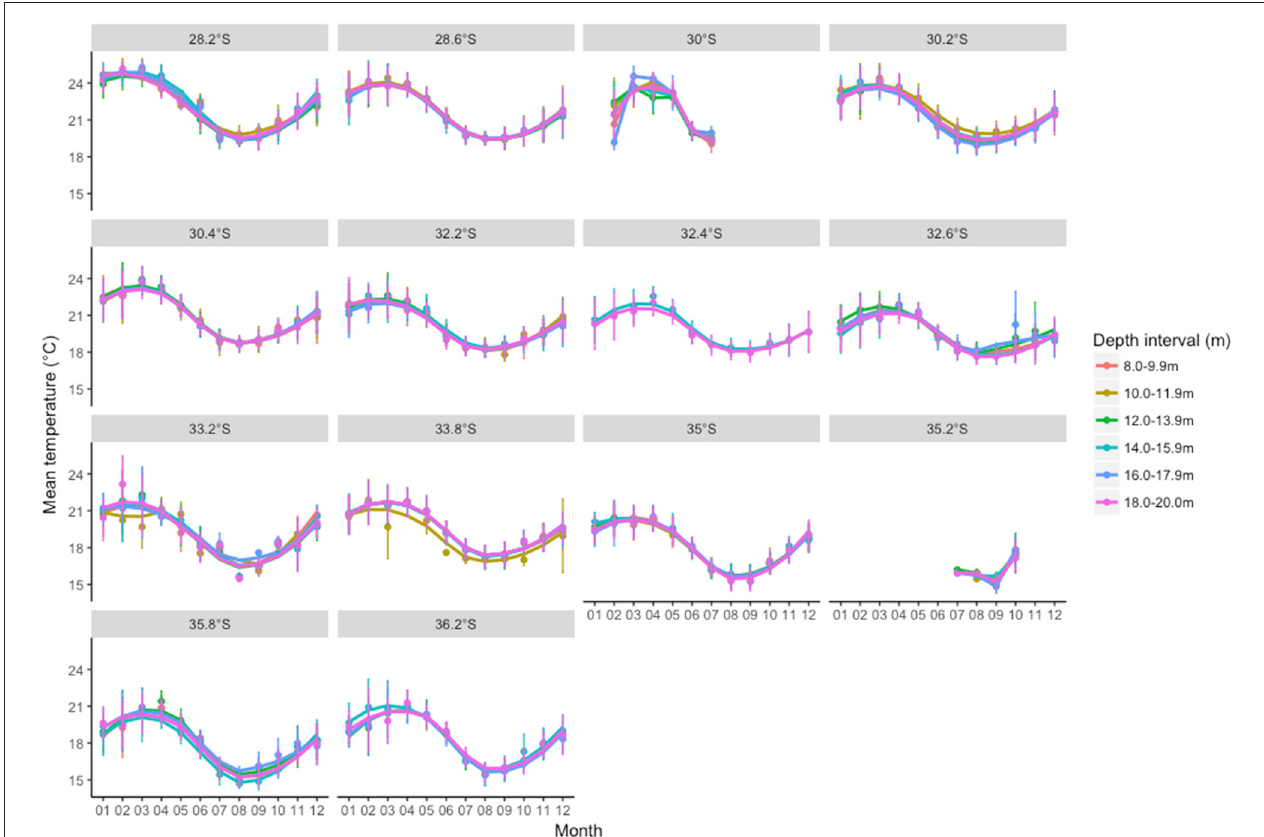
FIGURE 2 | Mean monthly temperatures for in situ locations across each 0.20 ◦ latitude and 10m depth intervals.